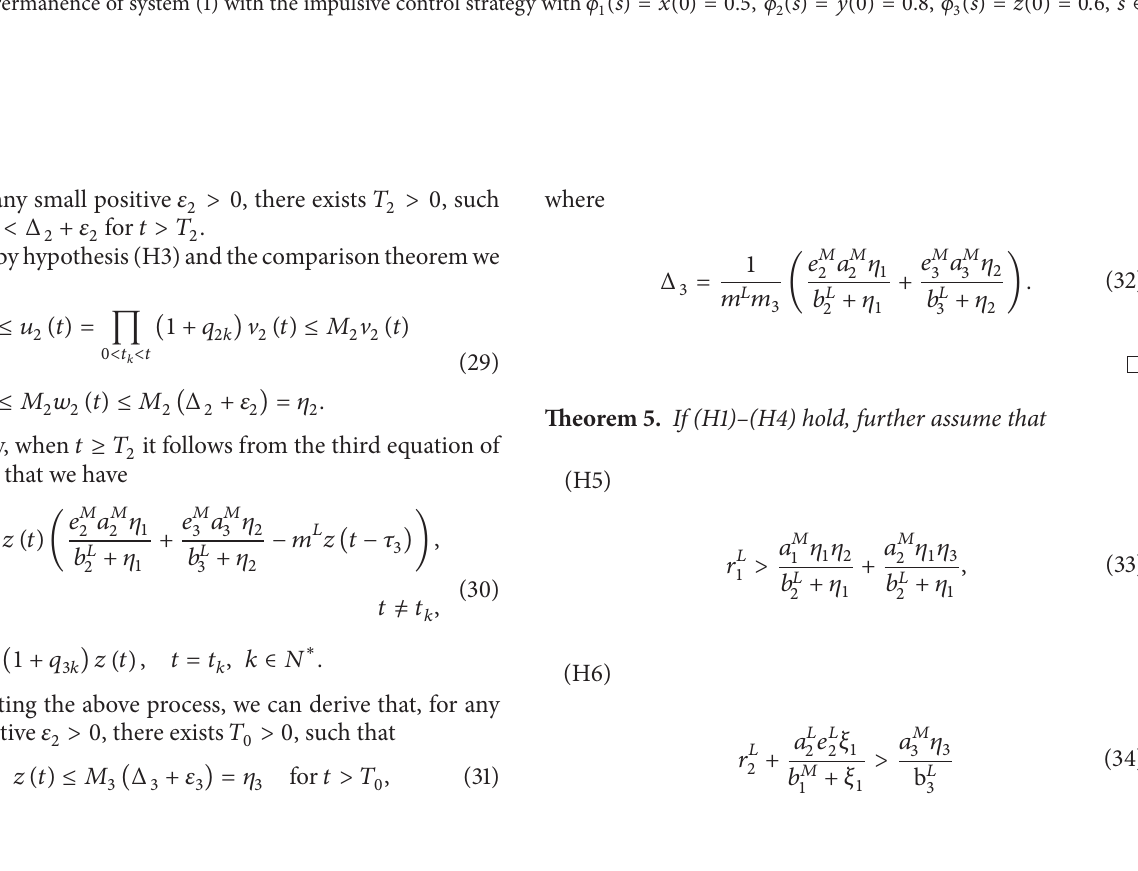
Figure 1: Permanence of system (1) with the impulsive control strategy with 𝜙 1 (𝑠) = 𝑥(0) = 0.5 , 𝜙 2 (𝑠) = 𝑦(0) = 0.8 , 𝜙 3 (𝑠) = 𝑧(0) = 0.6 , 𝑠 ∈ [−𝜏,0].